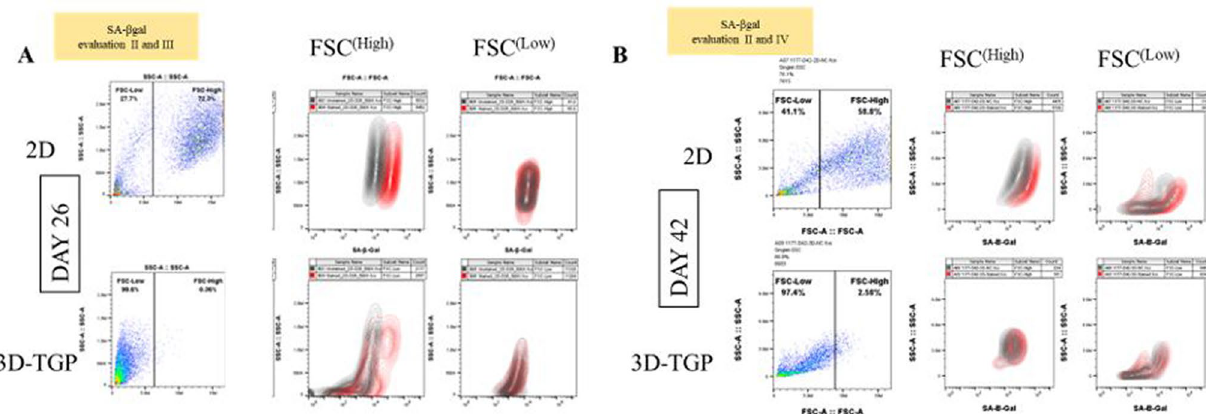
Figure 5. Gating in the flow cytometric analysis of osteoarthritic chondrocytes grown in 2D and 3D-TGP with the SA-βgal expression in two heterogeneous populations sorted by flow cytometry (FSC high versus FSC low ) with the 2D-grown cells showing higher SA-βgal expression than 3D-TGP cultured cells on both day 26 and day 42 of culture ( A ) Day 26; ( B ) Day 42. II, III and IV denote the Senescence-associated beta-galactosidase (SA-βgal) evaluation time-points as described in Fig.